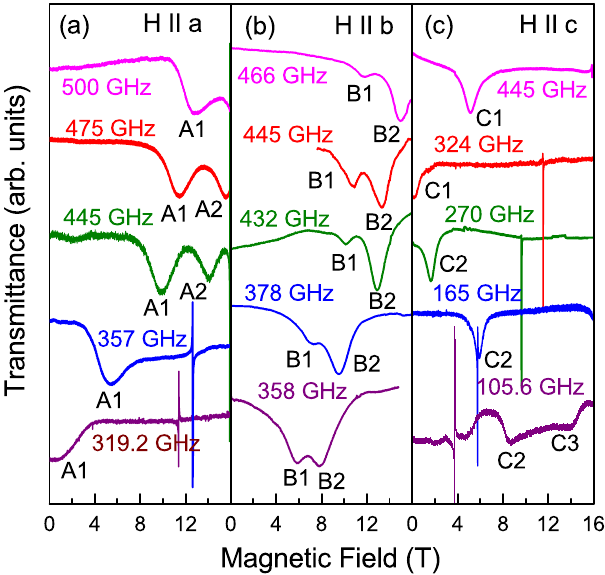
Fig. 3 | Exemplary ESR spectra. Fields are applied along the a ( a ), b ( b ), and c ( c ) axis ( T =2K). Narrow lines with g =2 correspond to DPPH, used as a marker.